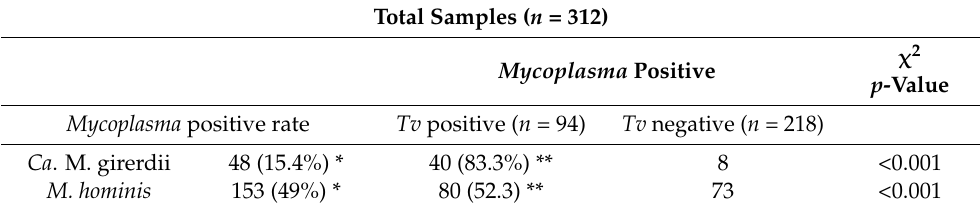
Table 3. Characteristics of Tv + women (cases) and Tv —women